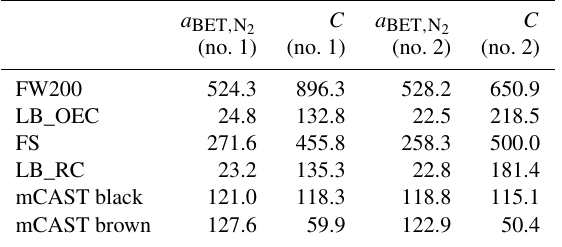
Table A1. Detailed results of the specific surface area measure- ments for the soot samples as determined by N 2 adsorption follow- ing the BET method. All specific surface area values, a BET , N given in units of (m 2 g − 1 ). The mean values are reported in Table 1. Besides, we report the values of the C parameter used in Eq. (A1) for the two independent experiments labeled no. 1 and no. 2, respec- tively.